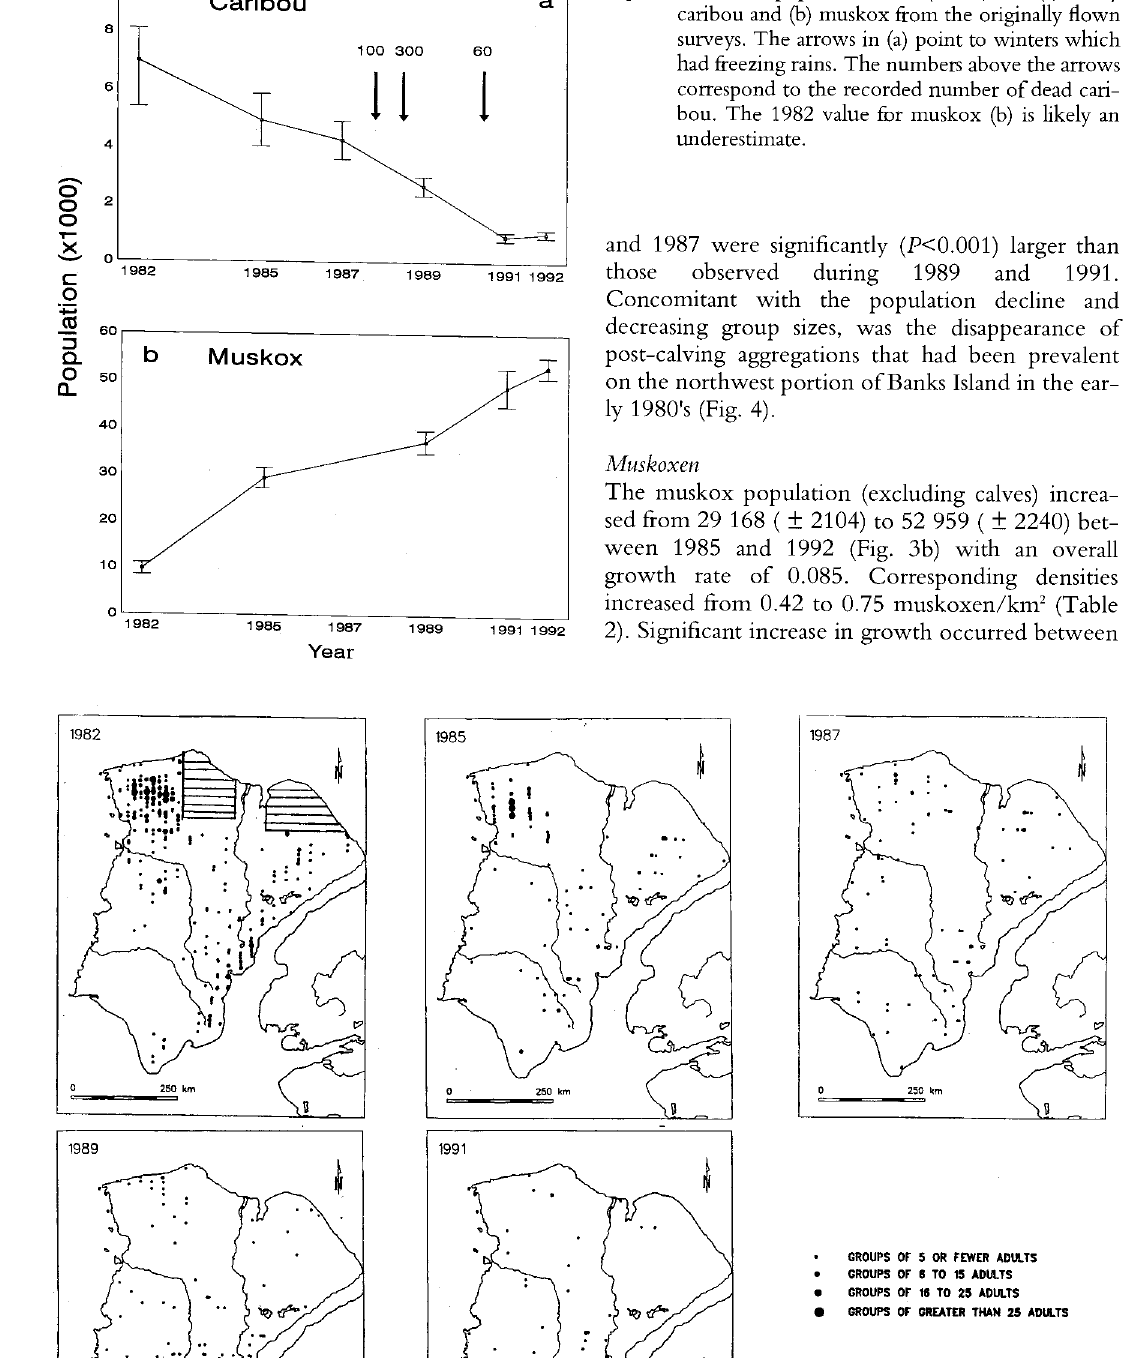
Fig. 3. Estimated population size (+ SE) for (a) Peary caribou and (b) muskox from the originally flown surveys. The arrows in (a) point to winters which had freezing rains. The numbers above the arrows correspond to the recorded number of dead cari bou. The 1982 value for muskox (b) is likely an